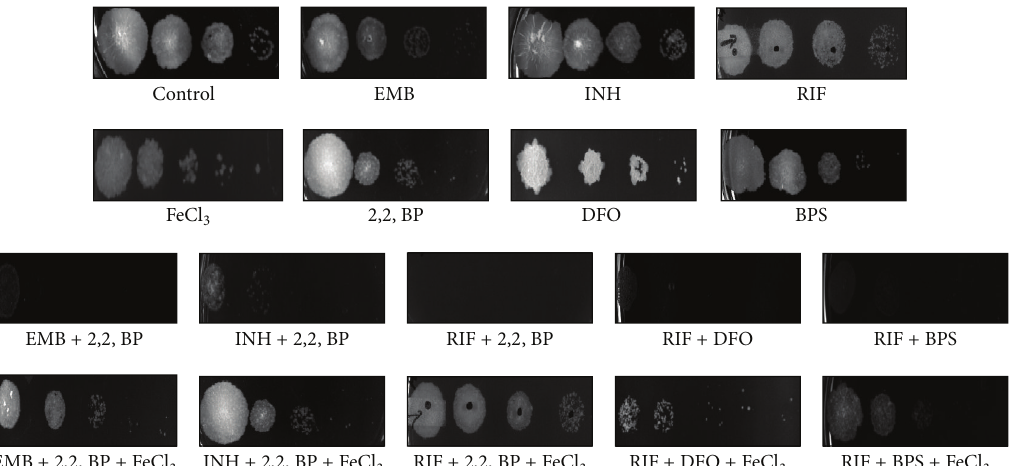
Figure 3: Effect of iron supplementation on reversion of drug susceptibilities. Spot assays of iron deprived cells (2,2, BP, DFO, and BPS) at concentrations of 35 𝜇 g/mL, 656 𝜇 g/mL, and 386 𝜇 g/mL showing hypersensitivity with EMB, INH, and RIF and upon iron supplementation (FeCl 3 ) of 0.2 mM for 2,2, BP, 0.3 mM for BPS, and 0.4 mM for DFO showing rescuing of the drug susceptibilities of EMB, INH, and RIF (62.5 ng/mL, 1 𝜇 g/mL, and 62.5 ng/mL).